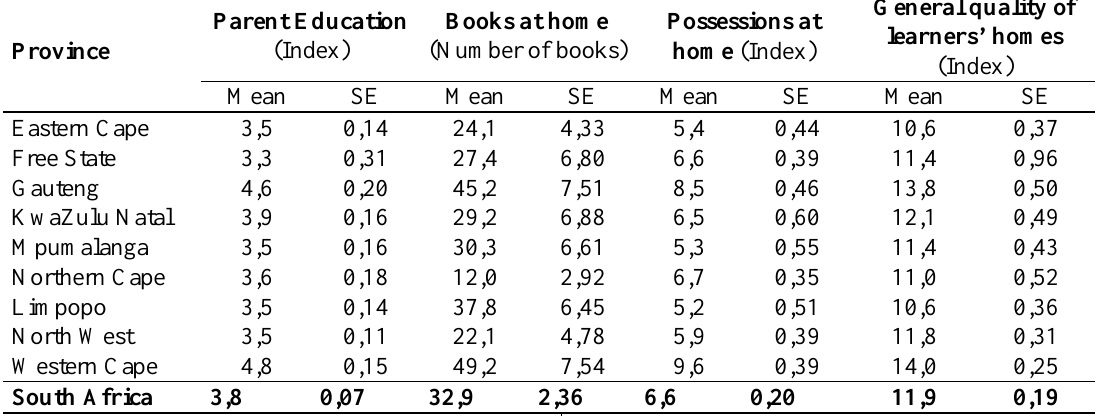
Table 2. Socio-economic characteristics: parent